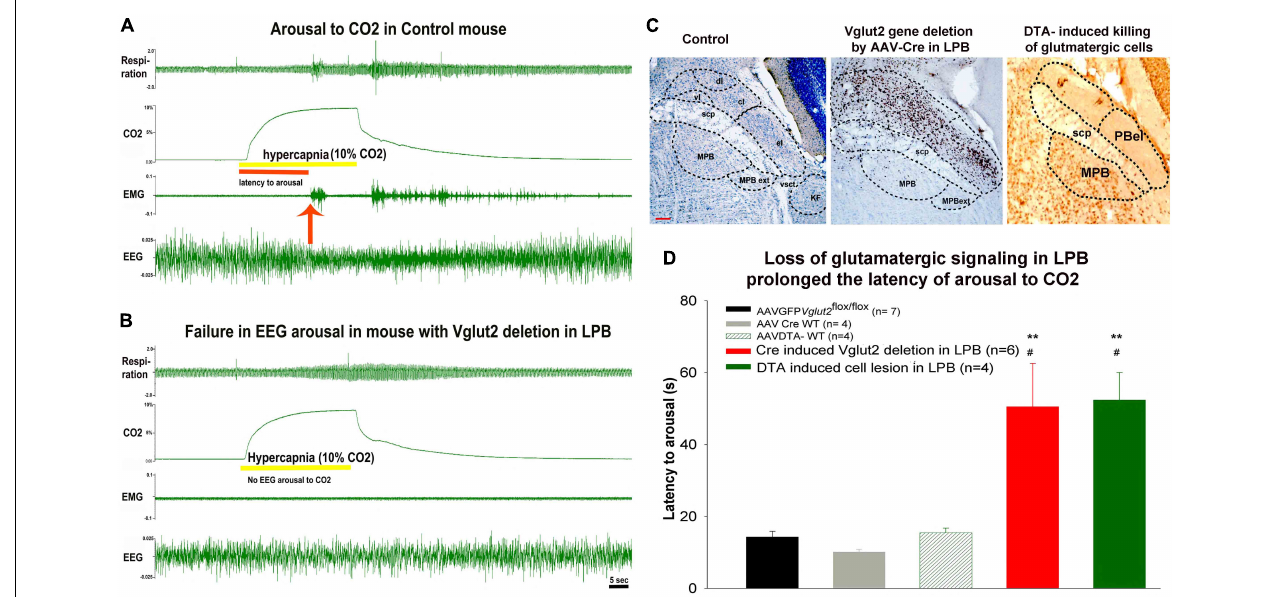
FIGURE 2 | Testing the role of glutamatergic signaling in hypercapnia induced arousal: (A,B) , are the two representative trials from a control mouse (A) , where cortcial EEG arousal in response to hypercapnia occurs in 15 s after onset of CO2, while the mouse with deletion of Vglut2 gene in the LPB (B) , fails to wake wake up to hypercapnia. (C) , Photomicrograph of the Nissl-stained coronal section of the mouse brain, showing different sub divisions of the parabrachial (PB) nucleus, Cre-immunoreactivity (brown) against a Nissl-stained background (blue) in the neurons in the lateral parabrachial (LPB) region after injection of AAV-Cre in Vglut2 flox / flox mice and last panel shows the shows a photomicrograph of a brain section immunostained for Neu-N, a neuronal marker after bilateral injection of AAV-DTA killed Vglut2 + neurons into the LPB. (D) , Show graphs of the latency of arousal during and after a hypercapnic stimulus of 30 s in mice injected bilaterally with AAV-DTA (green) compared to the control (black, gray, and striped green) and LPB group from which Vglut2 was deleted in the LPB including the PBel (red). scp – superior cerebellar peduncle; dl – dorso-lateral; cl – centro-lateral; el – external lateral; vl – ventrolateral PB subnucleus; MPB – medial and MPB-ext – medial external-lateral parabrachial nucleus; KF – Kolliker Fuse; vsct – ventral cerebro-spinal tract; Scale = 100 µ m. ∗∗ represents p < 0.01 compared to the control group (AAV-GFP) and # p < 0.05, compared to the AAVCreWT group. [Adapted and modified from Kaur et al. (2013)]. Kaur et al. (2013), is published under Creative Commons Attribution-Non-commercial-Share License, and therefore no permission is required reproducing this modified version.